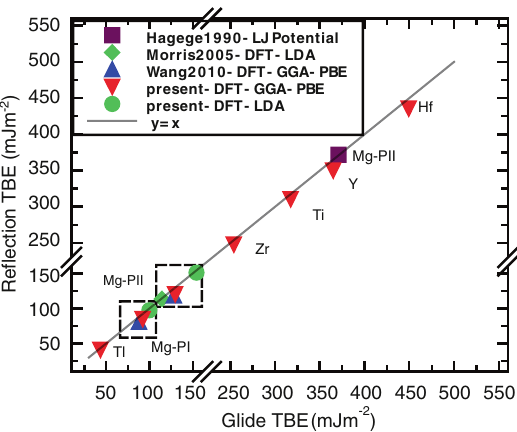
Fig. 3 Twin boundary energies of f 1011 g and f 1012 g twins computed by DFT and the Lennard – Jones potential. PI represents the f 1011 g compression twin, PII f 1012 g tensile twin. Unless explicitly pointed out, the other computed twin boundary energies are for f 1012 g twins Table 2. The TBEs of f 1012 g twins in Mg and fi ve other hcp metals Element